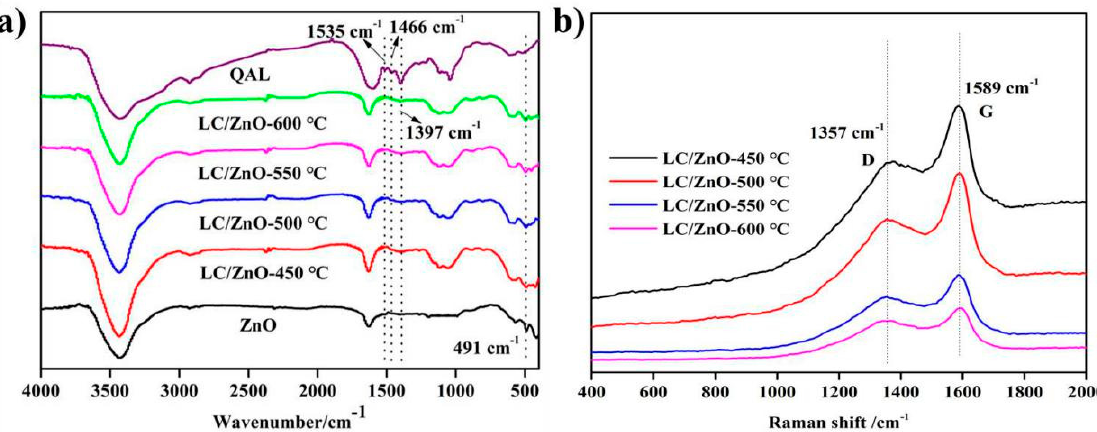
Figure 3. Spectra of LC/ZnO: ( a ) FT-IR; ( b ) Raman.